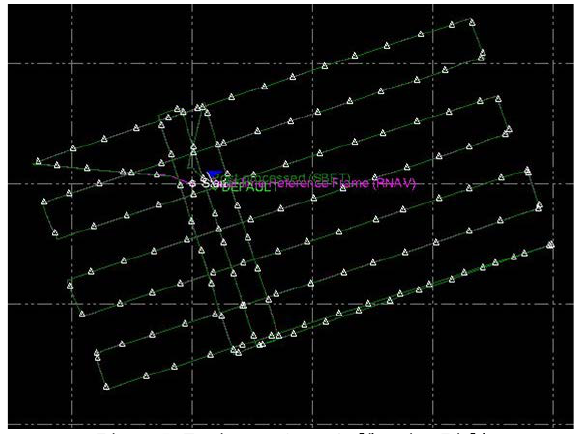
Figure 5: Trajectory Over Calibration Field